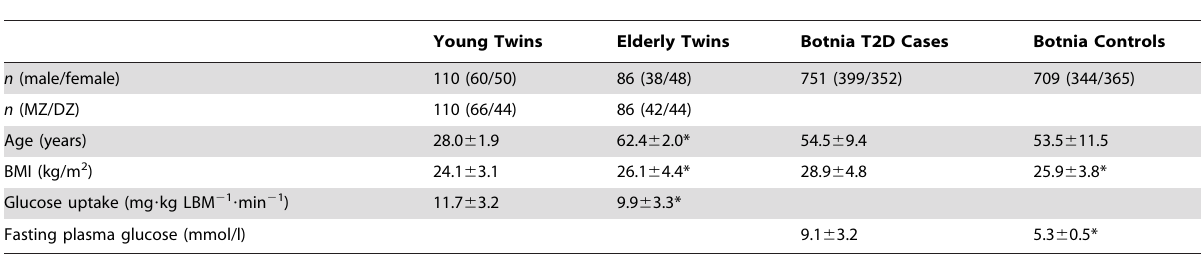
Table 1. Clinical characteristics of